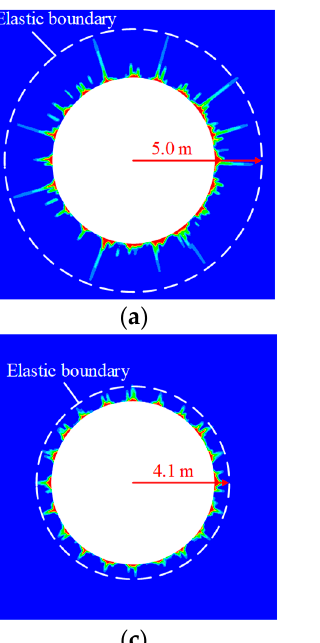
10 of 21 Figure 5. Numerical model of the multiple-hole blasting in the circular tunnel excavation (unit: m). 3.3. Seismic Energy Generation and Attenuation under Hydrostatic In Situ Stress 3.3.1. Seismic Energy on the Elastic Boundary The rock fracture caused by the blasting of the stoping holes in the fourth round un- der hydrostatic in situ stress is shown in Figure 6. This figure presents the fractured zones in the remaining rock mass under σ x = σ y = 0, 10, 30, and 60 MPa. As expected, the rock